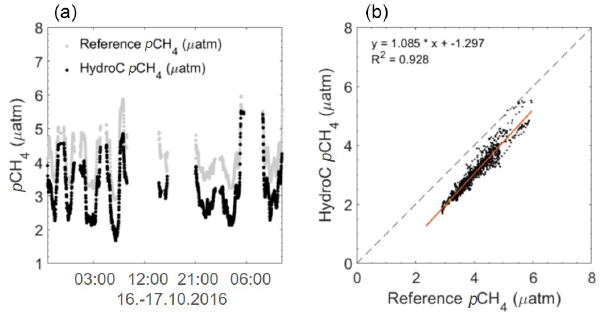
Figure 8. p CH 4 µatm data from the HC–CH 4 during the brackish cruise (EMB 142; RV Elisabeth Mann Borgese ) expedition in the western Baltic Sea, with the reference system over the first half of the cruise. Panel (a) shows the HC–CH 4 data with a negative offset, resulting in lower concentrations compared to that of the reference data. Panel (b) shows a 1 : 1 plot, with a regression line ( R 2 = 0 . 928) illustrating the constant offset, but with a similar slope of data. Within the brackish waters, the offset was within the spec- ifications from KMCON, yet both values (reference and HC–CH 4 ) were in the range of that previously found within the region (Gül- zow et al.,